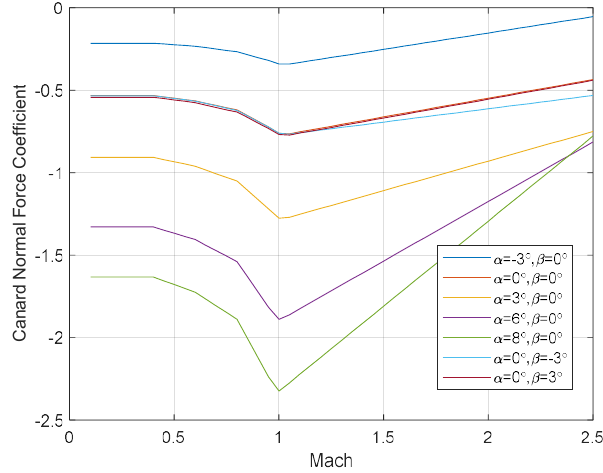
Figure 7. Canards Normal Force Coefficient.